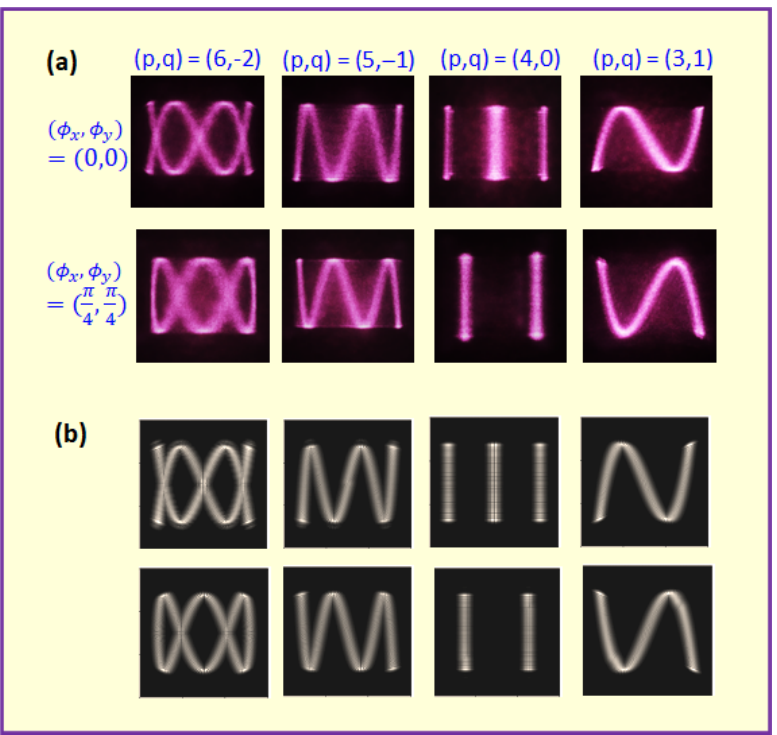
Figure 16. ( a ) Experimental results for the far-field patterns of Lissajous geometric modes with ( P , Q ) = ( 1, 4 ) for four different ( p , q ), the first row: φ x = φ y = 0; second row: φ x = φ y = π /4. ( b ) Numerical patterns calculated by using Equation (51) for one-to-one correspondence with ( a ).